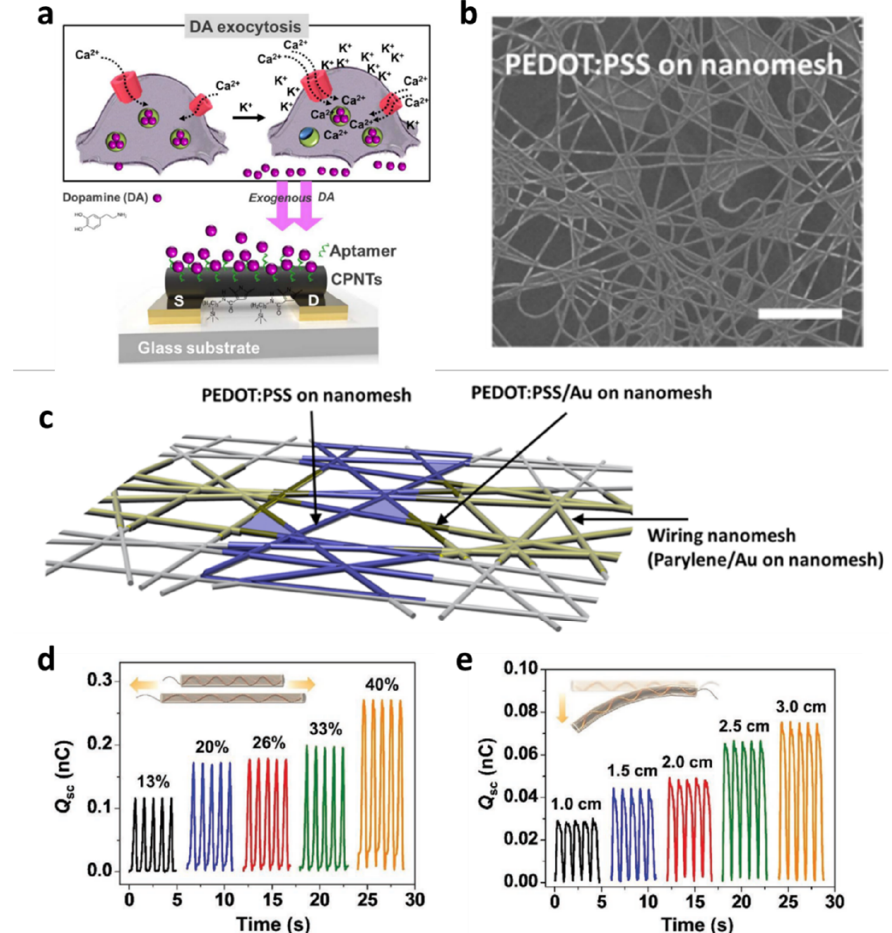
Figure 7. Nanotube and nanomesh structure devices. ( a ) Schematic of liquid-ion-gating for aptasensor-based oncarboxylated polypyrrole nanotubes. Reprinted from [61], copyright (2020) with permission from Springer Nature. ( b ) Enlarged image of PEDOT:PSS on nanomesh. ( c ) Nanomesh organic electrochemical transistor structure. Reprinted from [62], copyright (2020) with permission from American Chemical Society. ( d , e ) Measured Q sc of nanocomposite polymer electrolyte triboelec- tric nanogenerator under different mechanical energy harvesting patterns and bending. Reprinted from [63], copyright (2021) with permission from John Wiley and Sons.